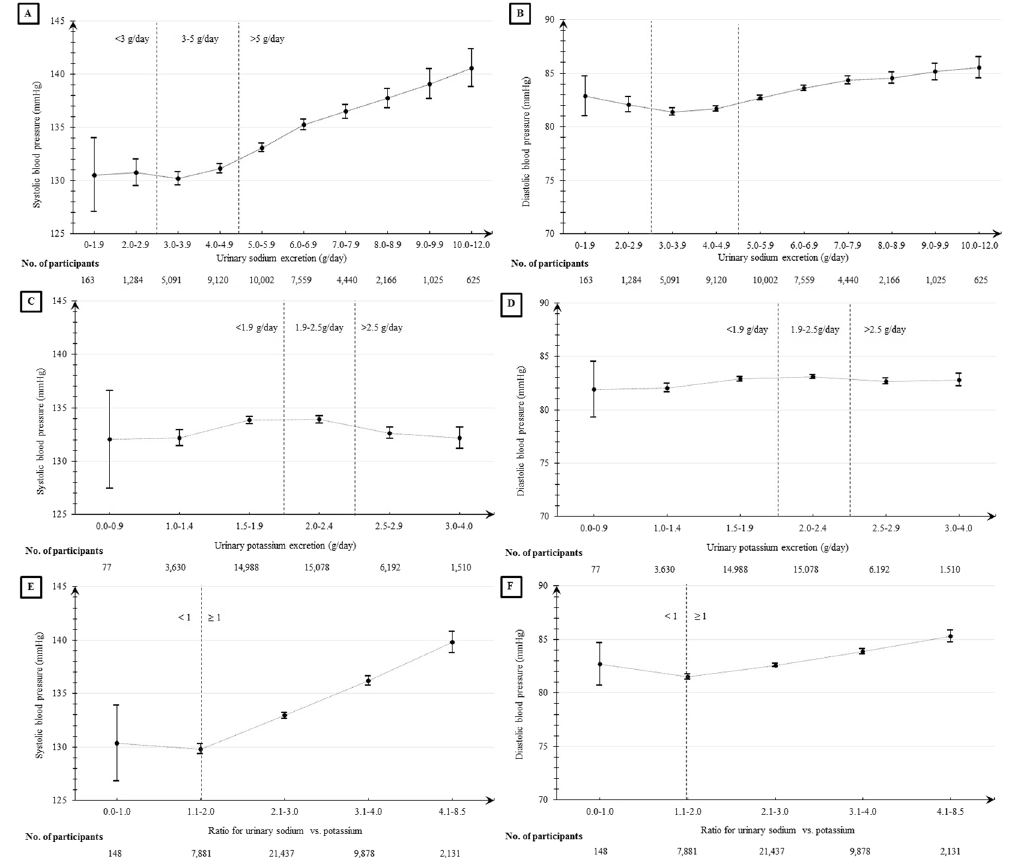
Figure 3. Means and 95% confidence intervals of systolic and diastolic blood pressure by urinary sodium excretion ( A , B ), potassium excretion ( C , D ), and ratio of sodium vs. potassium ( E , F